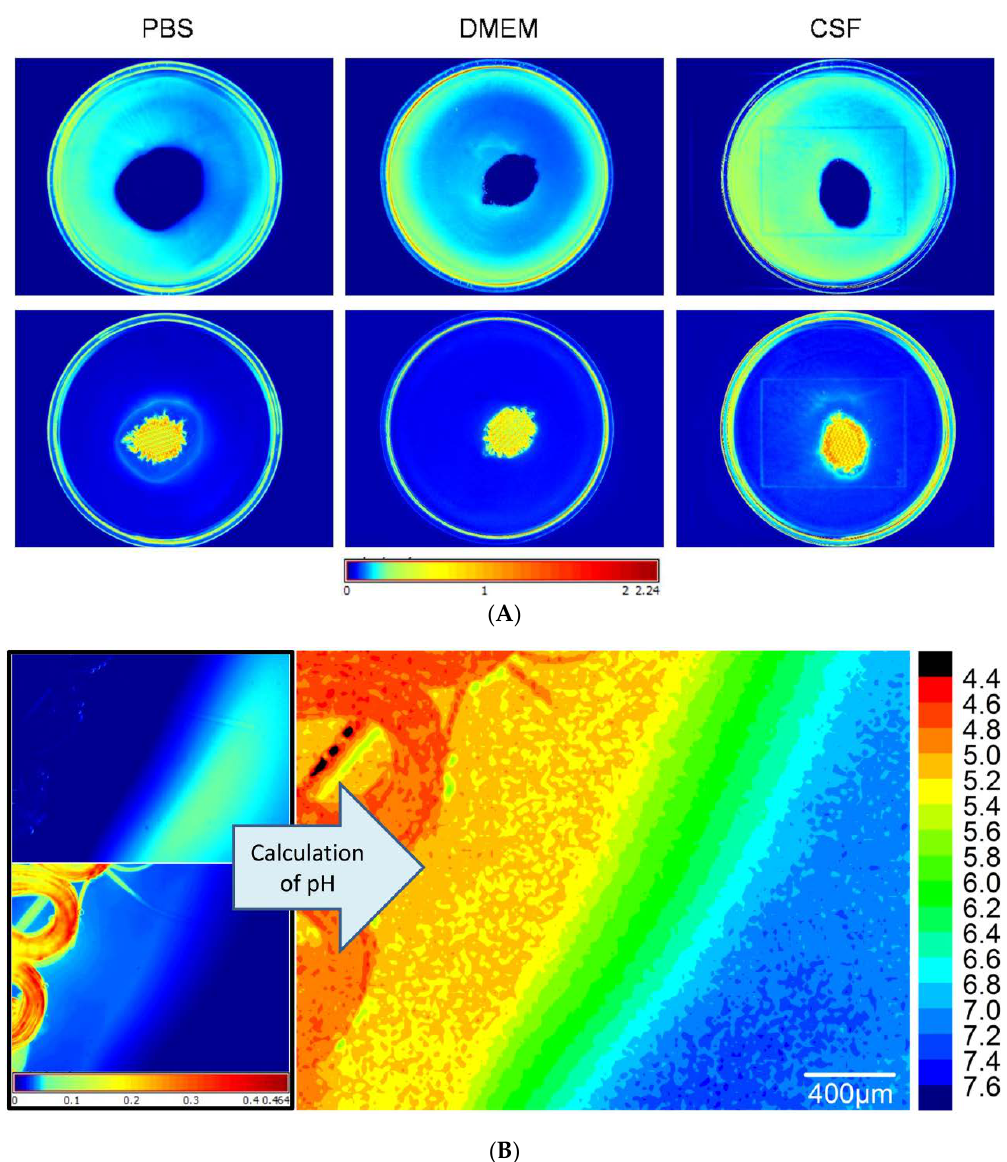
Figure 3. Analysis of ORC-dependent local pH in PBS, DMEM, and CSF determined with pH-sensitive fluorescence imaging and microscopy. ( A ) 5 cm diameter petri dish with SNARF in the medium and 95 mm² Tabotamp ® in the middle. The intensity distribution of the neutral spectrum is shown at the top and the acidic spectrum at the bottom. The colors were set with the Histogram eq. mode and the color map “jet”. The scale is in parts of the maximum intensity. The blue stands for low intensity and red for high intensities. The knitting structure is shown in orange. ( B ) Fluorescence microscope picture of Tabotamp ® in CSF. The left side shows the neutral and the acidic spectrum distribution. The right side presents the calculated pH as described in methods. The pH was calculated with a sigmoidal calibration curve (Figure S2).